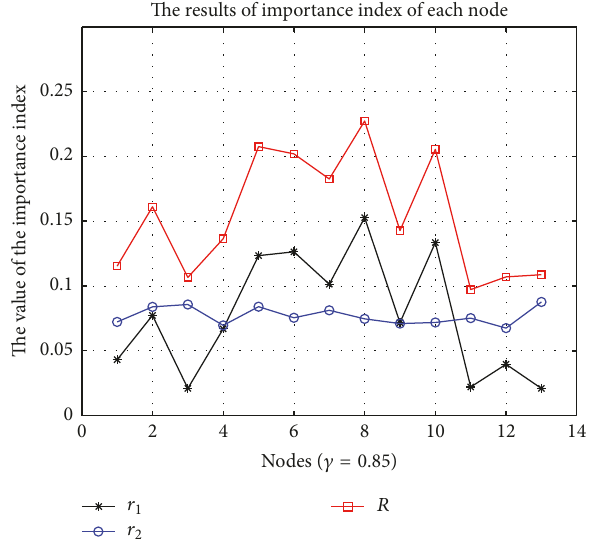
Figure 4: The values of the importance index of nodes when 𝛾 = 0.85